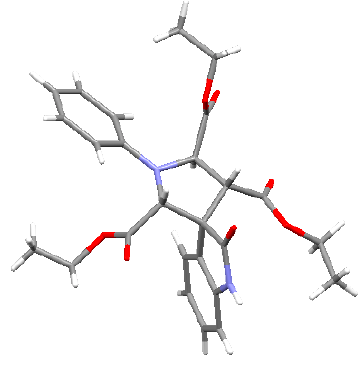
Figure 2. X-ray structure of 3a . Table 2. Evaluation of substrate scope under optimized reaction conditions a .